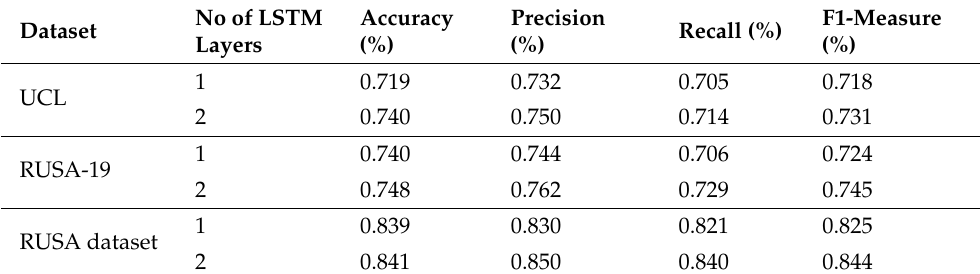
Table 6. Effect of LSTM layers on proposed Roman Urdu CNN-LSTM